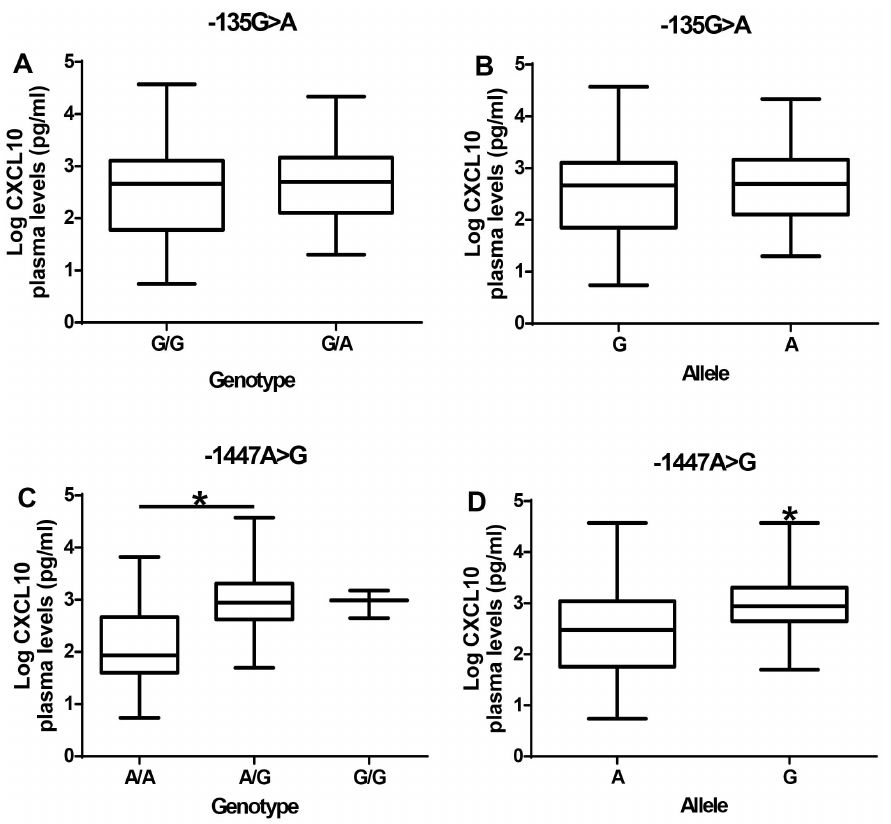
Figure 2. Effect of 2 135G . A and 2 1447A . G promoter polymorphisms on CXCL10 plasma levels. (A) Plasma CXCL10 levels among the genotype of 2 135G . A polymorphism. (B) Plasma CXCL10 levels among the allele of 2 135G . A polymorphism. (C) Plasma CXCL10 levels among the genotype of 2 1447A . G polymorphism. (D) Plasma CXCL10 levels among the allele of 2 1447A . G polymorphism. Box plot represent log- transformed medians with 25 th and 75 th percentiles, bars for 10 th and 90 th percentiles. Significant differences of CXCL10 median levels between the groups were determined by Mann-Whitney U test or Kruskal Wallis test with Dunn’s multiple comparisons tests. Asterisk (*) indicates a significant difference (p , 0.05).